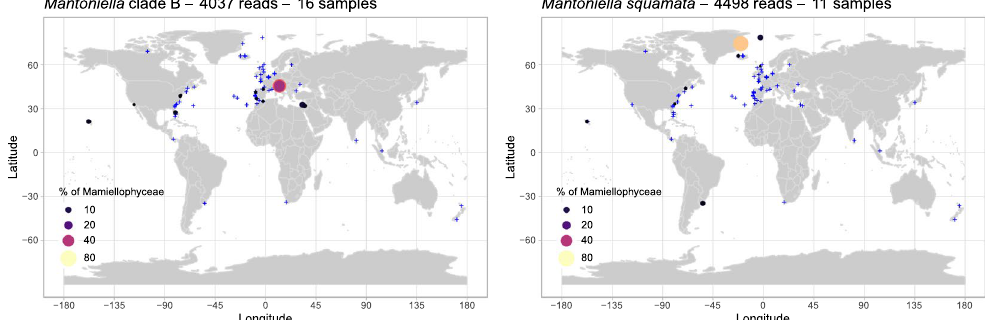
Figure 8. Distribution of the major Mantoniella ASVs for OSD2014 (LGC). Legend as in Fig. 3. A zoomed-in map of European waters is provided in Fig.